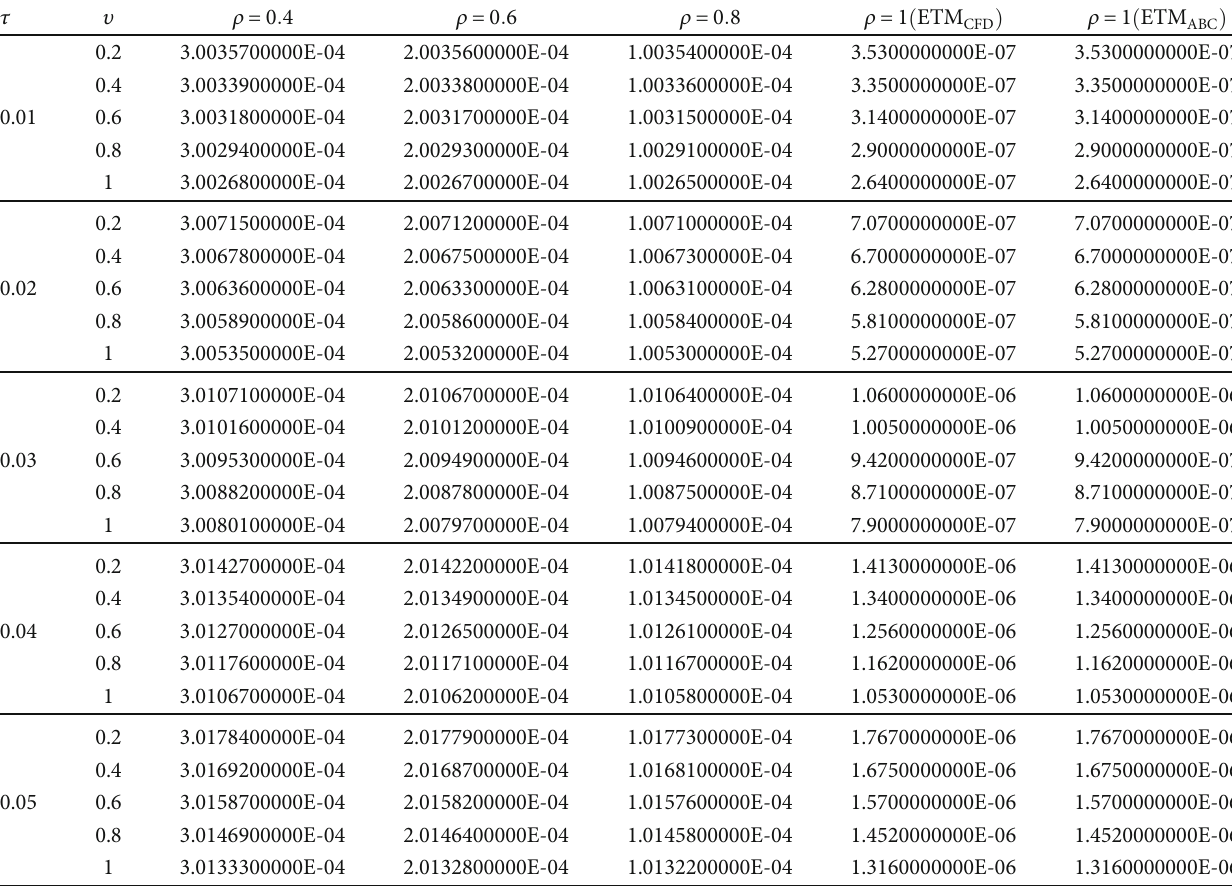
Table 1: Comparison of absolute errors of proposed method solution at various fractional-orders with a , b = 1 for problem